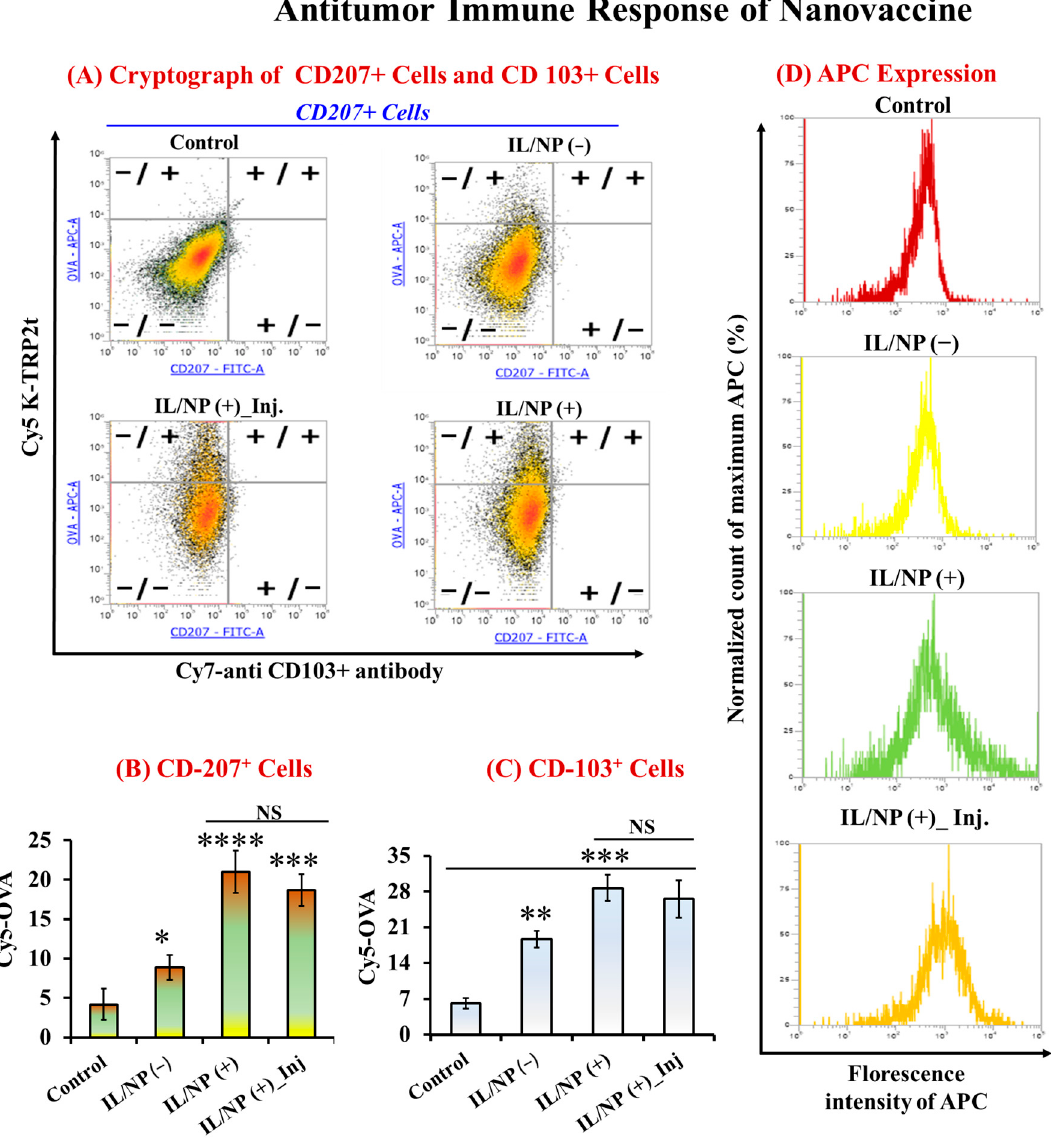
Figure 6. Antitumor immune response to the nanovaccine was investigated with flow cytometry using multichannel beam ( A ) cytograms, ( B ) Expression of the CD-207+ cells, ( C ) Expression of the CD-103+ cells, and ( D ) florescence intensity of APCs in skin tissues. Data are presented as the mean ± SD (n = 3). * p < 0.1, ** p < 0.01, *** p < 0.001, **** p < 0.0001, and NS = not significant. Inj = administered via subcutaneous injection.